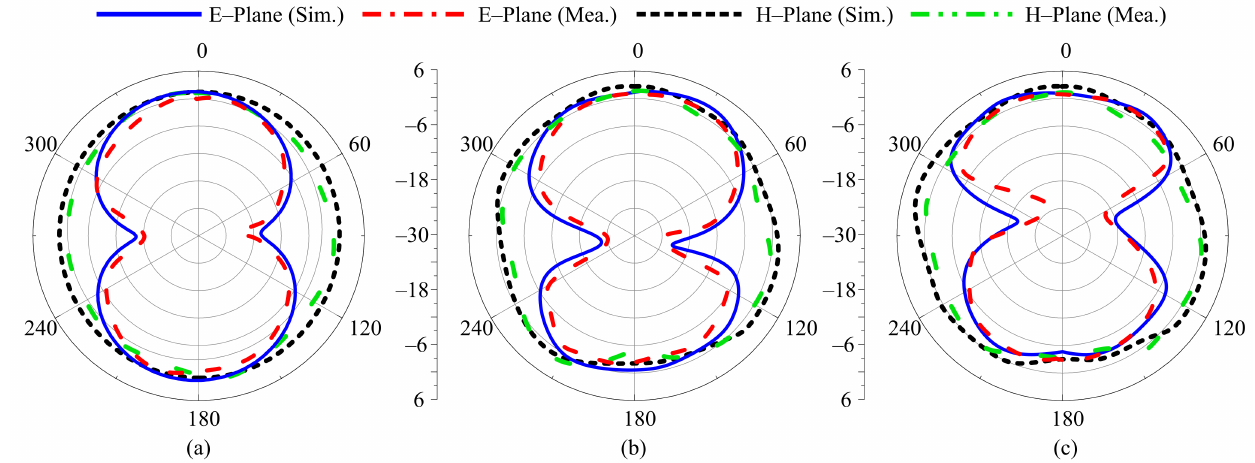
Figure 15. Simulated and measured radiation pattern of proposed antenna at 1.9 GHz for